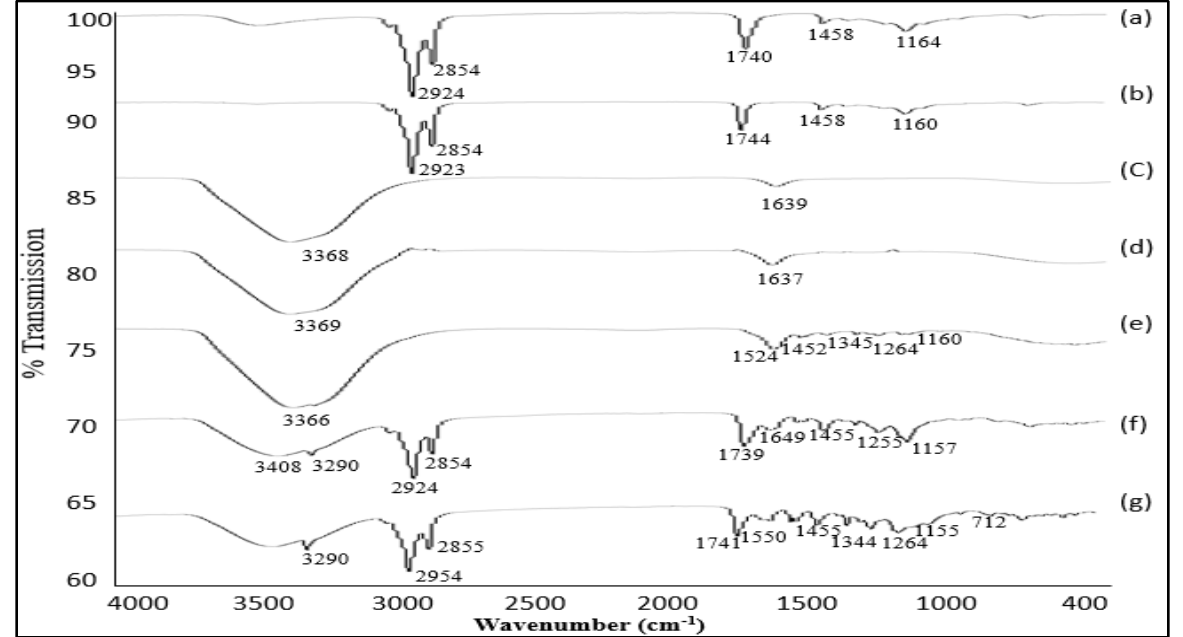
Figure 2. FT-IR spectra of flaxseed oil ( a ); coriander oil ( b ); tizanidine ( c ); chitosan, thiolated chitosan, and tizanidine mixture ( d ); Eudragit RL100, PVP, and tizanidine mixture ( e ); PVP, flaxseed/coriander oil, and tizanidine mixture ( f ); and PVP, Eudragit RL100, flaxseed/coriander oil, and tizanidine mixture ( g ).